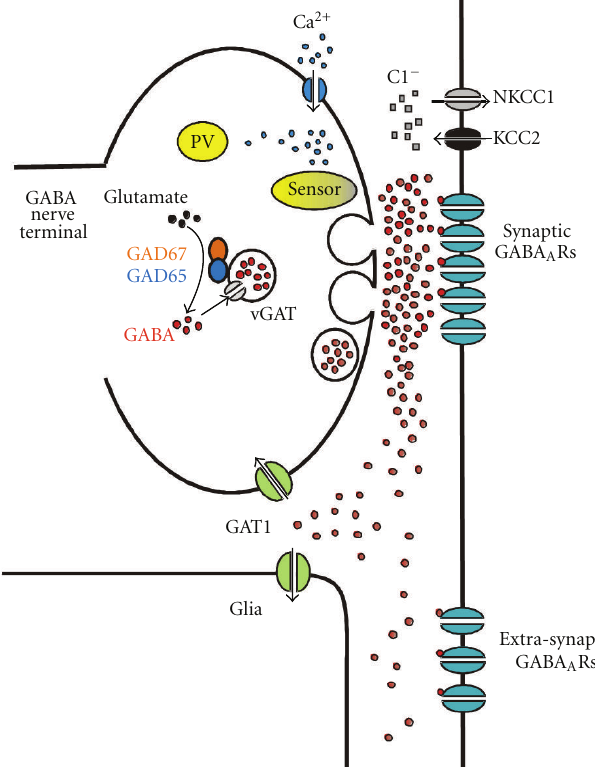
Figure 1: Scheme showing a nerve terminal from a parvalbumin- (PV-) positive GABA neuron shortly after an action potential triggered Ca 2+ -dependent GABA release, highlighting components currently hypothesized to be altered in schizophrenia. In PV terminals, GABA release is tightly synchronized with Ca 2+ influx, possibly due to the proximity between voltage-dependent Ca 2+ channels and release sites. PV is a relatively slow bu ff er that probably is unable to bind Ca 2+ before activation of the Ca 2+ sensor promotes vesicle fusion. Ca 2+ bu ff ering by PV mainly accelerates the decay of the intraterminal Ca 2+ transient (see text). GAD65 and GAD67, possibly acting as a dimer, drive GABA synthesis in the cytosol near synaptic vesicles. Vesicles uptake newly synthesized GABA via the vesicular GABA transporter vGAT. Vesicle fusion rapidly and transiently raises GABA concentration in the synaptic cleft, briefly exposing post-synaptic GABA A receptors (GABA A Rs) to a high concentration of GABA. As GABA escapes from the synaptic cleft after GABA A R activation, it may be taken up by the plasma membrane GABA transporter GAT1, apparently localized in the extrasynaptic neuronal membrane, as well as in glia. GAT1 therefore regulates the concentration of GABA reaching extrasynaptic GABA A Rs and synaptic GABA A Rs at other synapses (not shown in the scheme). The direction and magnitude of the chloride current produced by postsynaptic GABA A R activation is regulated by the transporters KCC2 and NKCC1, which uptake and extrude chloride, respectively, setting the equilibrium potential for the GABA A current, E GABA accelerates the decay of the intraterminal Ca 2+ transients, a decrease of PV in schizophrenia may facilitate repetitive GABA release, such as that observed during gamma oscillation episodes. A decrease of GAD67 levels in schizophrenia would reduce the cytosolic GABA concentration near synaptic vesicles. Because vGAT levels appear to be una ff ected in schizophrenia, reduced GAD67 may lead to lower intravesicular GABA concentration, therefore decreasing the peak GABA concentration in the synaptic cleft and weakening the postsynaptic response. In schizophrenia, at some synapses postsynaptic GABA A R density appears to be decreased, further weakening synaptic transmission, whereas at other synapses GABA A R density is increased, possibly due to compensatory receptor upregulation. In schizophrenia, KCC2 and NKCC1 mRNA levels are normal, but two kinases that strongly regulate KCC2 and NKCC1 may be altered in ways that render an E GABA depolarizing than normal. Finally, reduced GAT1 in schizophrenia may alter the e ff ects of synaptically released GABA via an exaggerated activation of extrasynaptic and heterosynaptic GABA A Rs. Alternatively, GAT1 activity may be reduced to compensate lower GABA levels due to GAD67